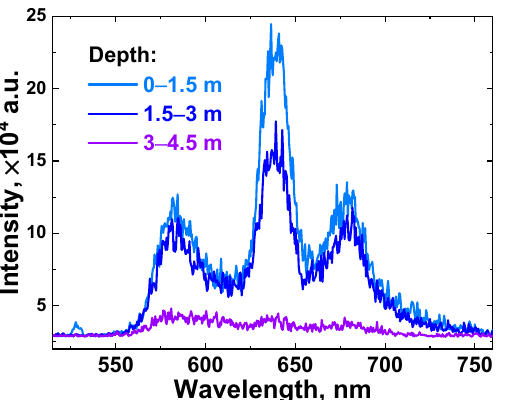
Figure 7. LiDAR raw spectra acquired in situ at different depths (light blue line—0–1.5 m; blue line—1.5–3 m; and violet line—3–4.5 m) in the vicinity of measurement spot № 15 (see Figure 2).